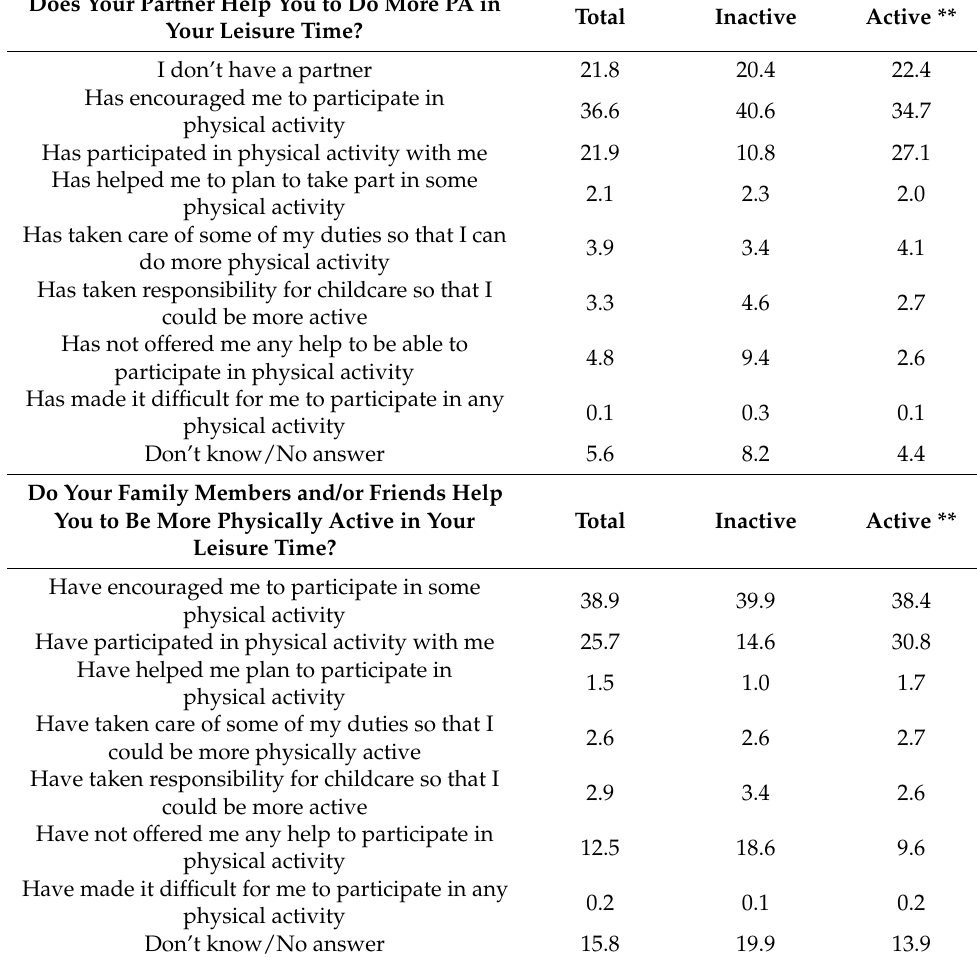
Table 6. Responses (%) of total, inactive, and active group participants regarding support from partners, family members, or friends to engage in